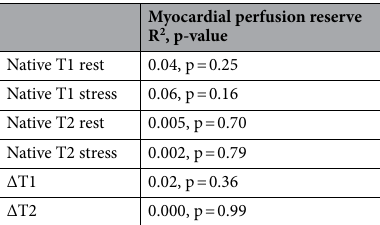
Table 5. Relationship of native T1 and T2 with myocardial perfusion reserve.